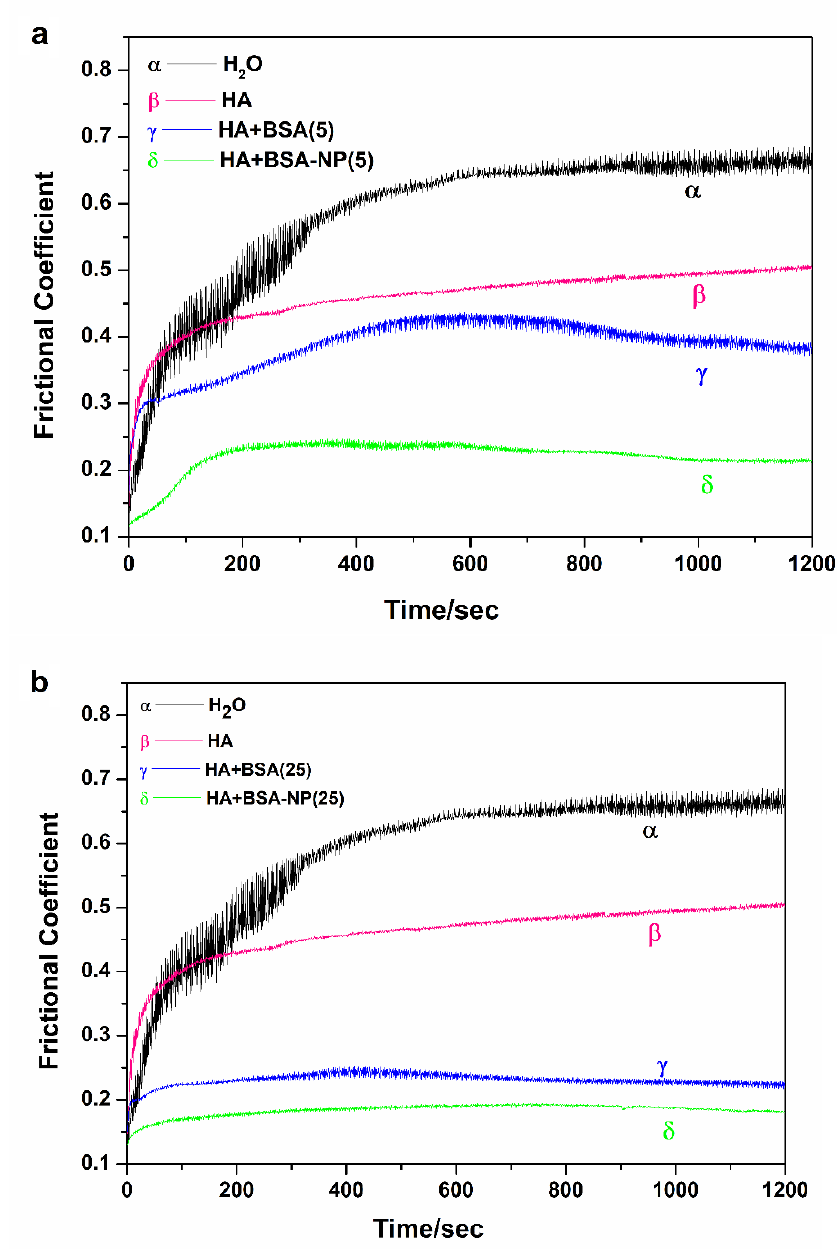
Figure 3. Frictional coefficient of H 2 O, HA and bionic synovial fluids containing different concentra- tions of BSA and BSA-NPs: ( a ) 5 wt% and ( b ) 25 wt%, under a load of 2 N, with the velocity equaling 8 mm/s, ZrO 2 -on-ZrO 2 .